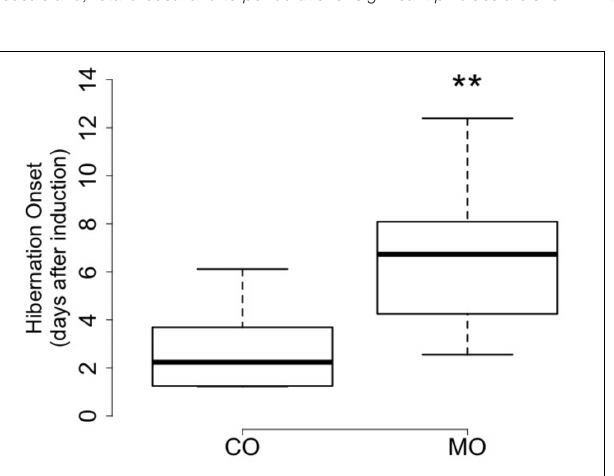
FIGURE 1 | Number of days until onset of hibernation after removal of food and water in October of by garden dormice fed the n-6 PUFA-enriched (“CO”) or n-3 PUFA-enriched (“MO”) diet (boxplots, ∗∗ p < 0.01).